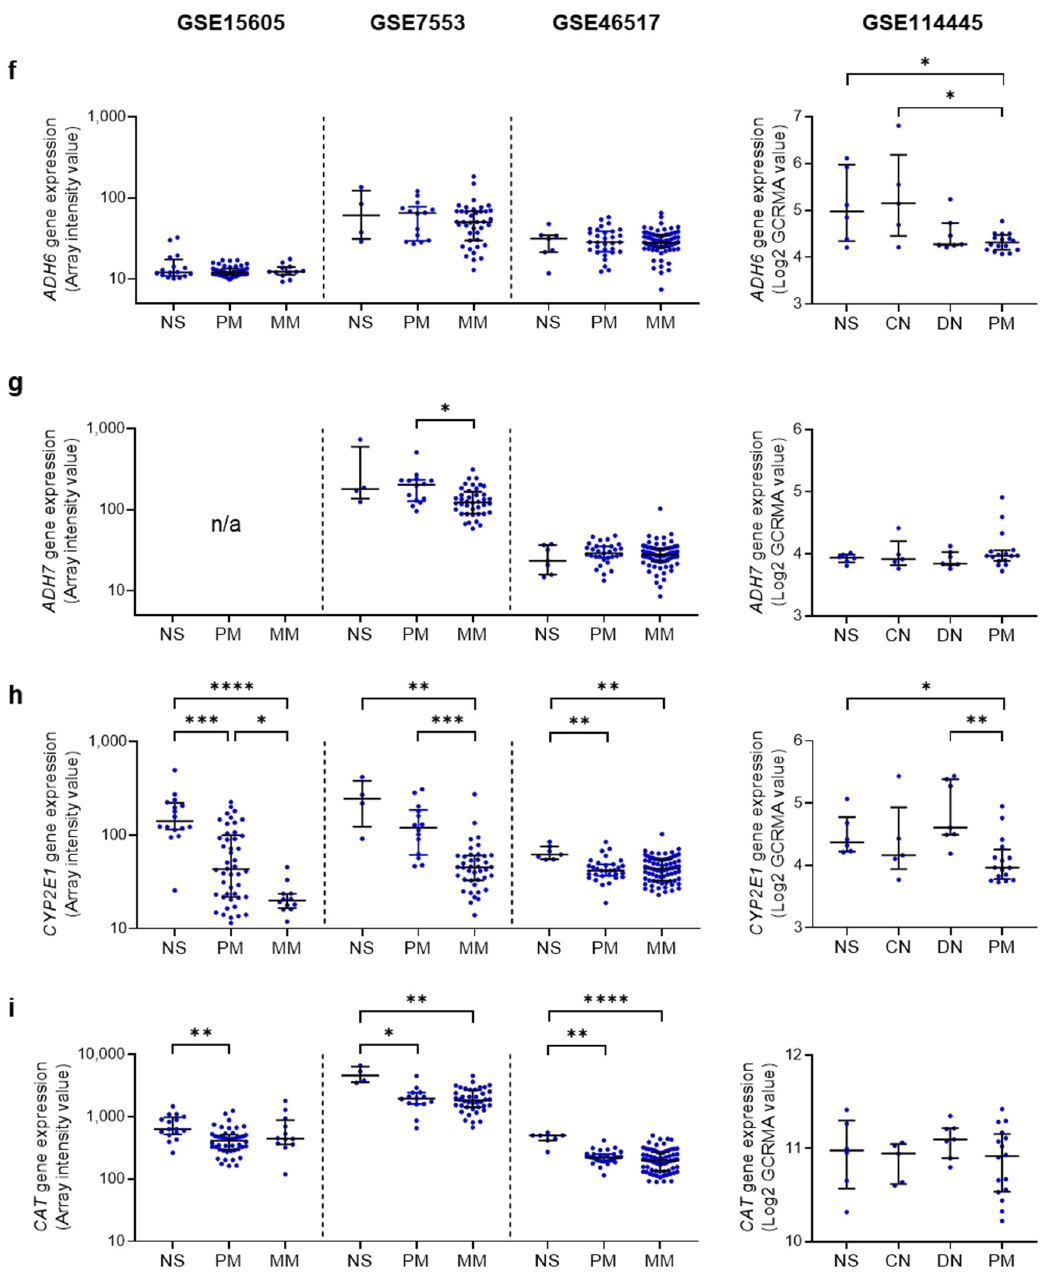
Figure 3. Gene expression of ethanol metabolizing enzymes in normal human skin, melanocytic nevi, and melanoma. Ethanol metabolizing enzyme genes include ADH1A ( a ), ADH1B ( b ), ADH1C ( c ), ADH4 ( d ), ADH5 ( e ), ADH6 ( f ), ADH7 ( g ), CYP2E1 ( h ), and CAT ( i ). Data from four independent gene profiling studies were analyzed: GSE15605 (16 normal skin (NS) samples, 46 primary melanoma (PM) samples, and 12 metastatic melanoma (MM) samples [149]), GSE7553 (4 NS, 14 PM, and 40 MM [150]), GSE46517 (7 NS, 31 PM, and 73 MM [151]), and GSE114445 (6 NS, 5 common nevus (CN) samples, 7 dysplastic nevus (DN) samples, and 16 PM [152]). In these datasets, if two or more probes were used for a certain gene, the gene expression values of these probes per patient were averaged since they used the same controls. Data are shown as scatter dot plot with median and interquartile range (IQR). * p < 0.05, ** p < 0.01, *** p < 0.001, and **** p < 0.0001 (Kruskal–Wallis’s non-parametric test (GSE15605, GSE7553, and GSE46517) and nonparametric estimation of Spearman's rank correlation (GSE114445)). n/a, not available.